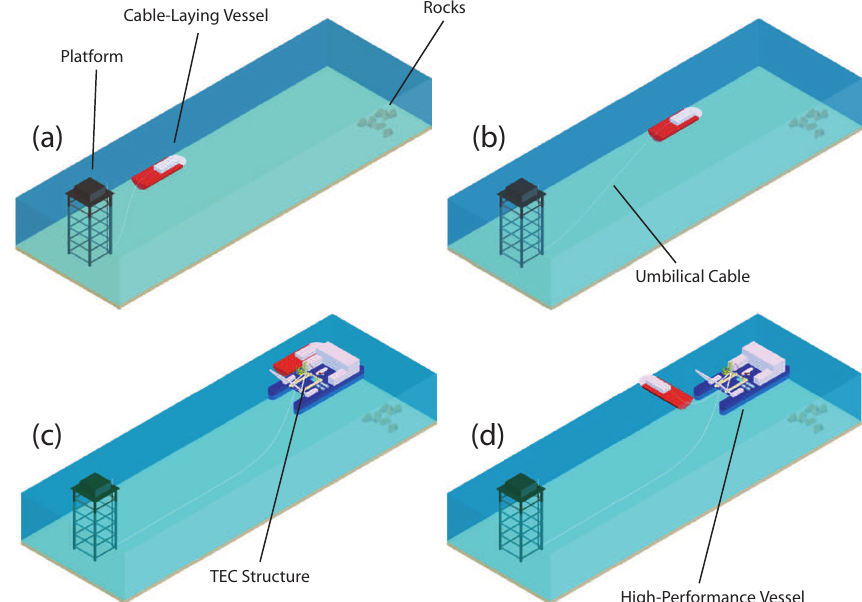
Figure 1. Installation sequence at tidal farm level: ( a ) joining the umbilical cable to the platform by means of a cable-laying vessel; ( b ) umbilical cable-laying process; ( c ) connection of the umbilical cable to the TEC (Tidal Energy Converter) structure; and ( d ) cable-laying process of the next umbilical